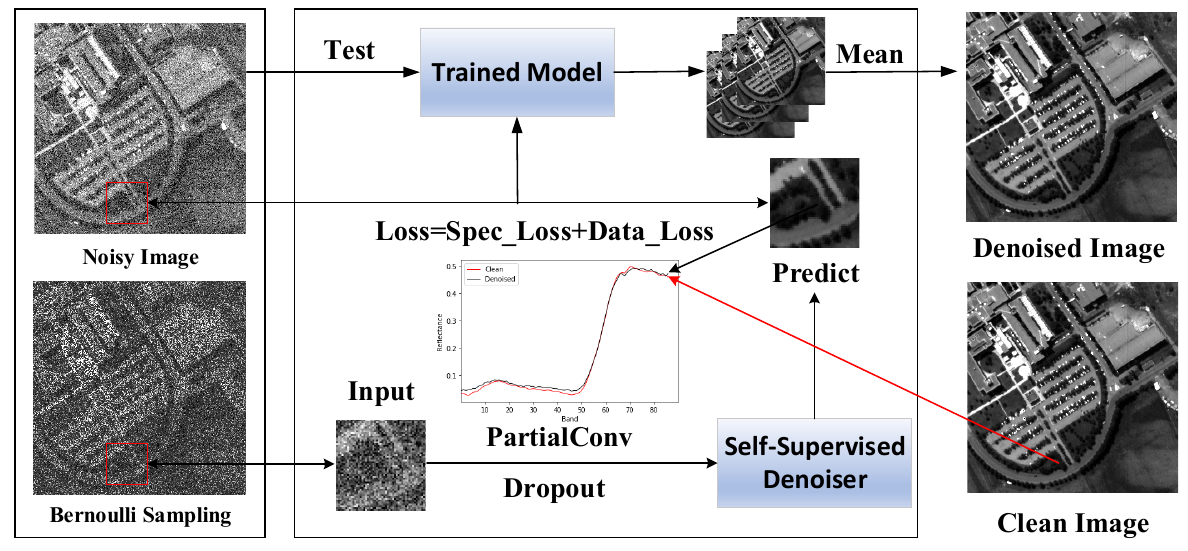
Figure 2. Network architecture of 3S-HSID including constructed image pairs and self-supervised denoising model.